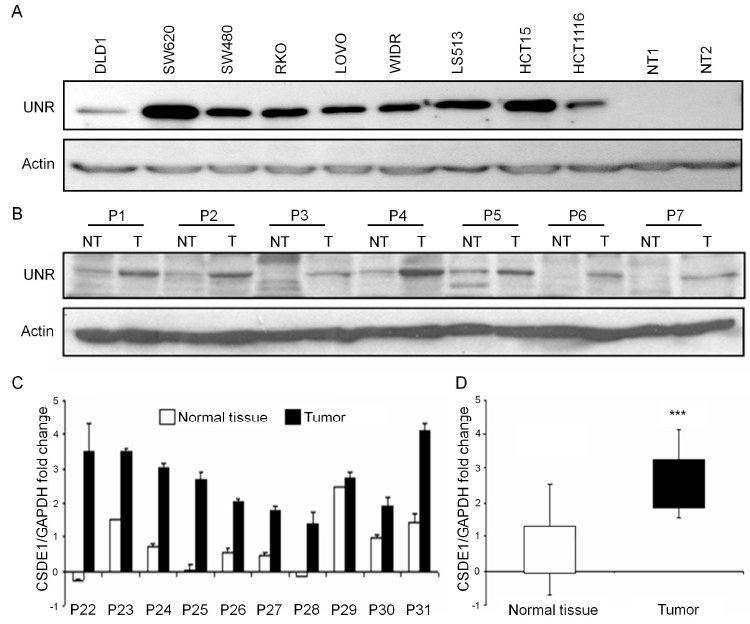
Figure 1. UNR / CSDE1 is overexpressed in CRC cell lines and tumor samples from patients. ( A ) UNR was overexpressed in all human derived colorectal cancer cell lines compared with two human untransformed mucosa tissues (NT1, NT2). ( B ) Seven representative pair of protein samples from 21 independent paired of patient tissues (P1–P7) were analyzed by Western blot, showing UNR overexpression in tumor samples (T) compared to their adjacent normal tissues (NT). ( C ) Ten independent paired of samples, tumor and untransformed tissues (NT) from patients diagnosed with CRC were analyzed by Real Time PCR. CSDE1 mRNA was overexpressed in most of tumor samples. ( D ) Samples were grouped by origin and statistical analysis was assessed (*** p <